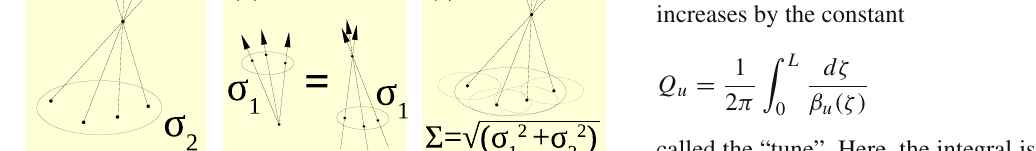
(cid:4) σ 2 + σ 2 1